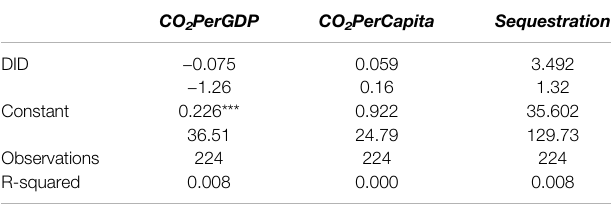
TABLE 9 | Counterfactual results for Huaihua City.